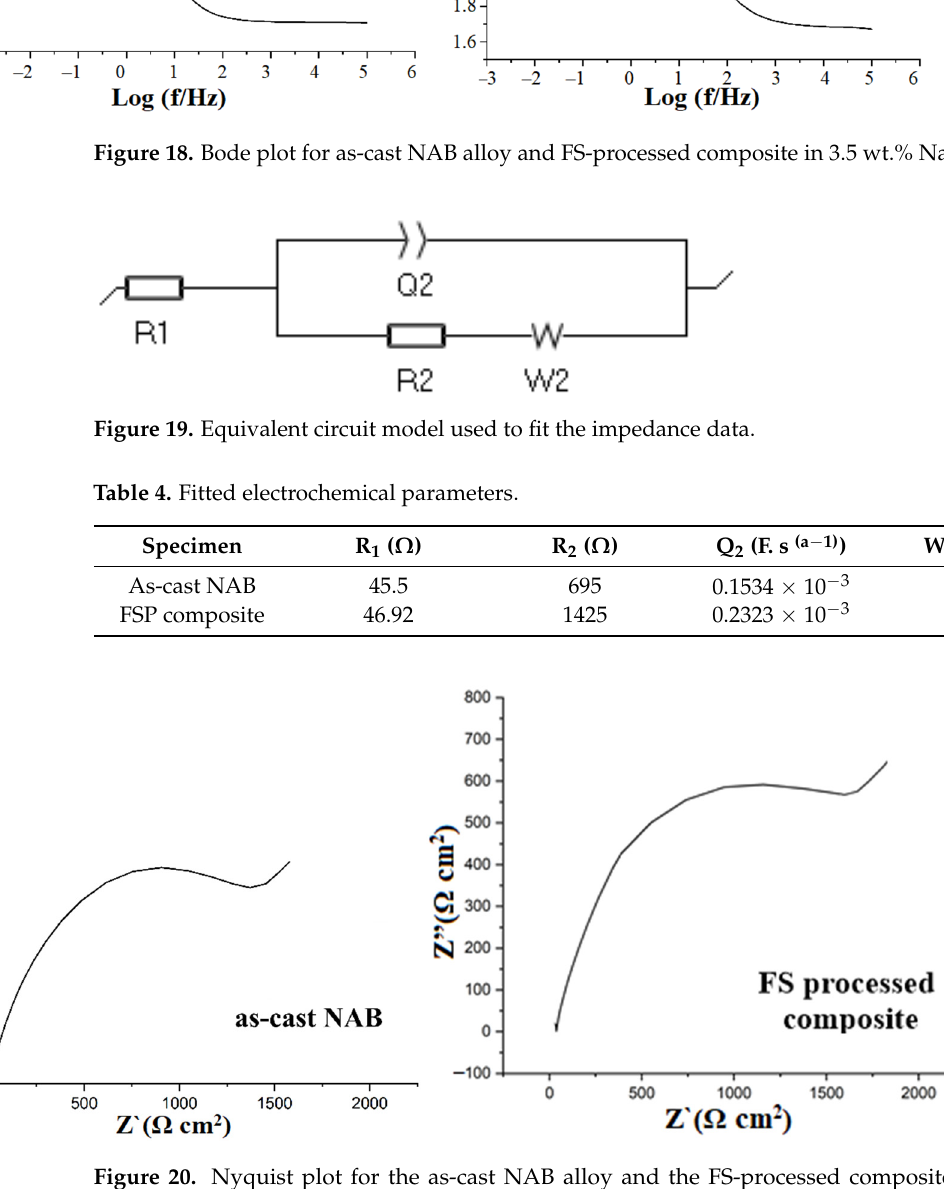
Figure 20. Nyquist plot for the as-cast NAB alloy and the FS-processed composite in 3.5 wt.% NaCl solution. NaCl Table 4. Fitted electrochemical parameters.